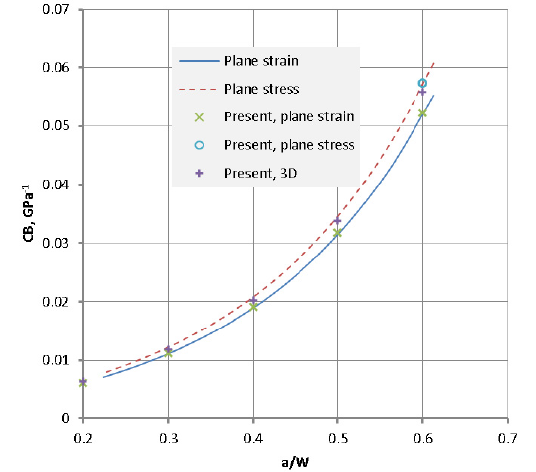
Figure 2: Variation of CMOD compliance with a/W. Figure 3: Expanded portion of Fig.